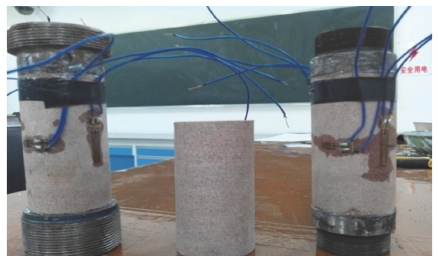
Figure 1: Rock specimens.